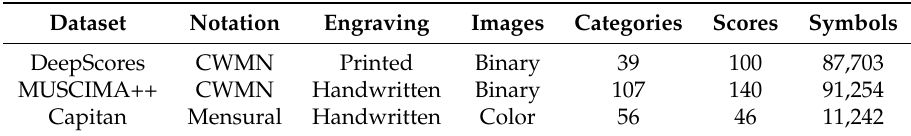
Table 1. Overview of the considered datasets.